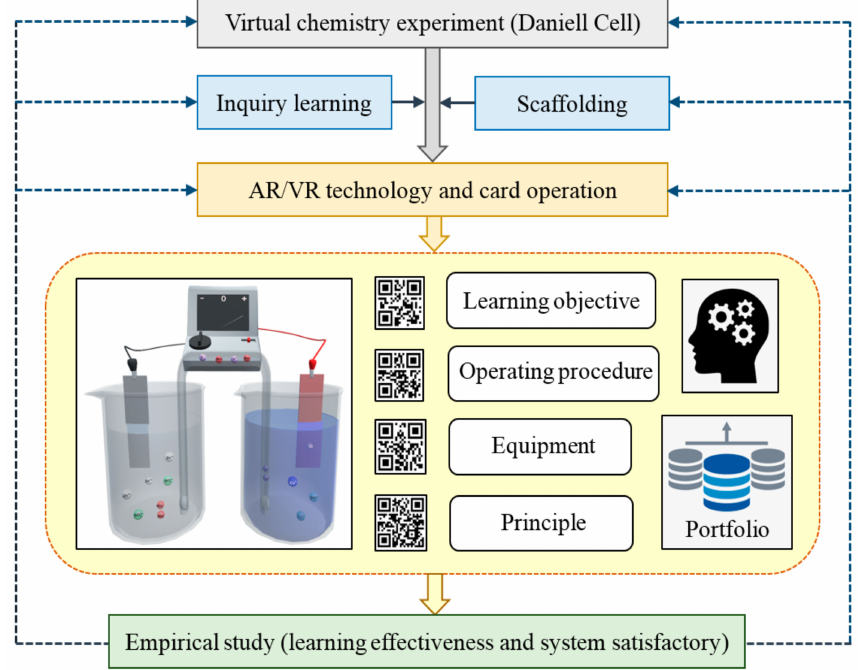
Figure 2. Research structure of the augmented reality (AR)-based virtual